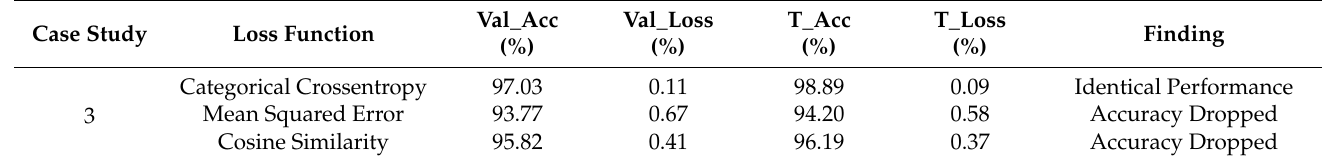
Table 8. Changing the Loss Function to evaluate the ablation study.